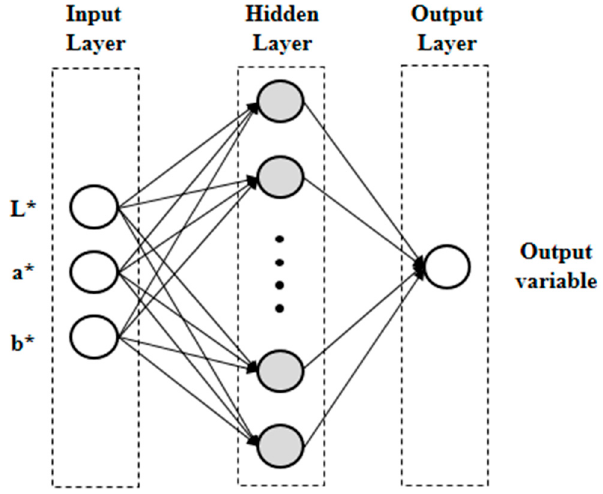
Figure 1. Structure of the multi-layer perceptron artificial neural network. The output variables are flesh firmness (FF), total soluble solid content (TSS), titratable acidity (TA), total phenolic content (TPC), antioxidant activity (AA), total monomeric anthocyanin (TMA). L* = lightness; a* = redness; b* = yellowness.